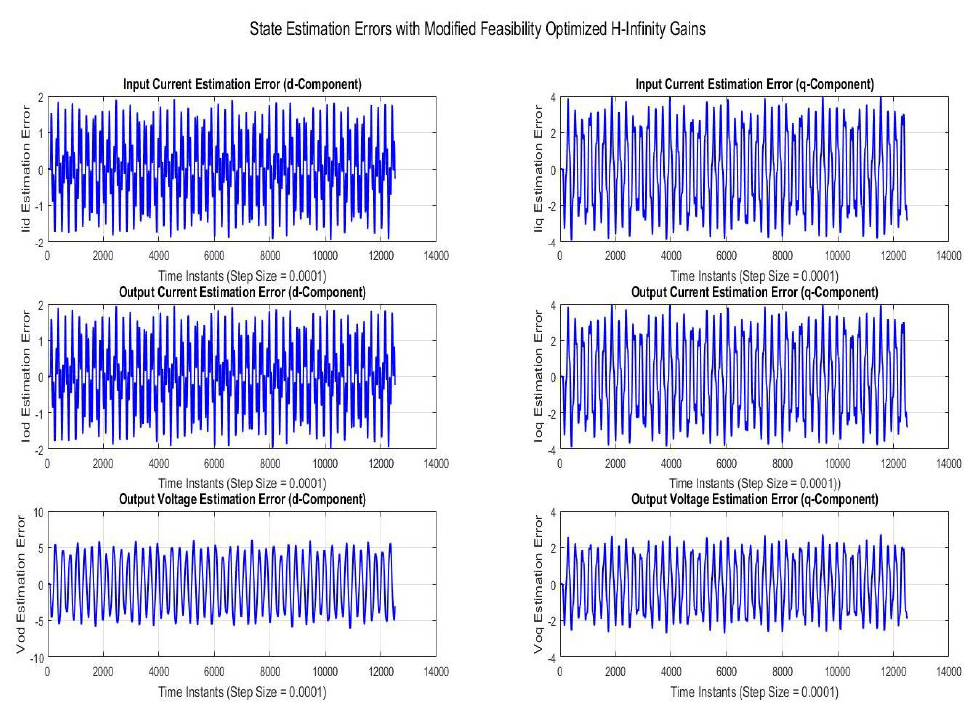
Figure 7. Fault diagnostic observer based state estimation error (dq-components). Figures 8 and 9 are showing the voltage and current faults estimation/reconstruction using SMOs using the gains optimized with Trace optimization, feasibility optimization of H ∞ constrained LMIs, and trace/feasibility optimization of Ricatti equation